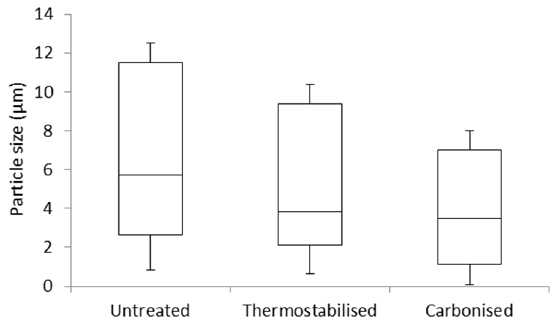
Figure 2. Particle size distribution of untreated, thermostabilised and carbonised organosolv lignin particles (outliers are not displayed; the box and whisker diagram is based on the minimum (lower whisker), the first quartile (bottom edge), the median (centre line), the third quartile (upper edge) and the maximum (upper whisker)).